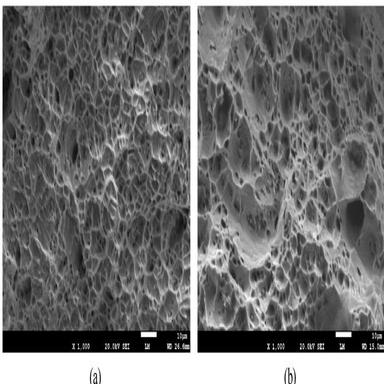
Fractogaphy of micro-tensile along (a) Build direction (b) Along Scan direction.